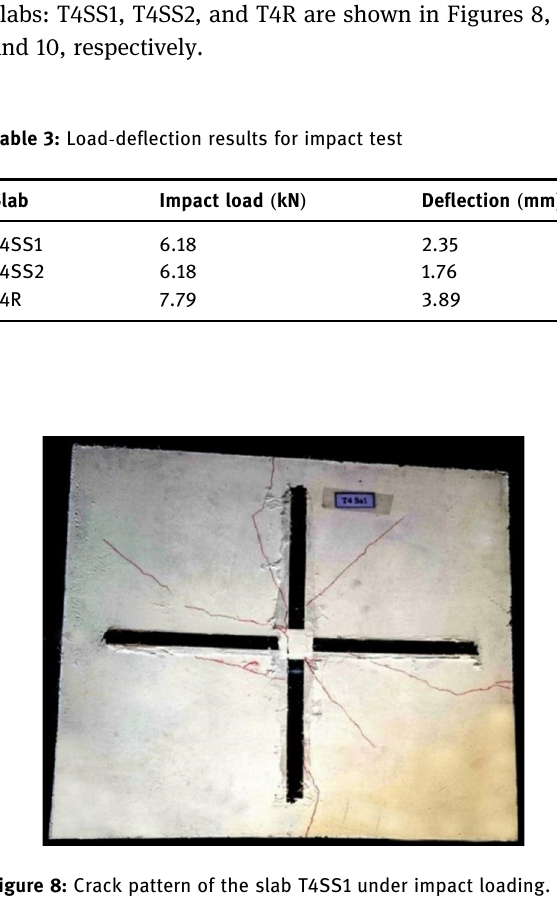
Figure 8: Crack pattern of the slab T4SS1 under impact loading.